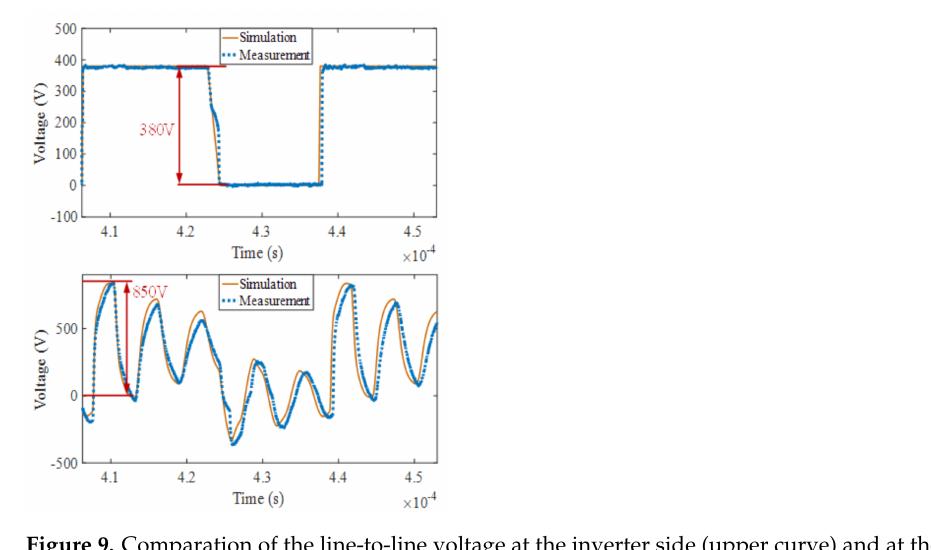
Figure 9. Comparation of the line-to-line voltage at the inverter side (upper curve) and at the motor side (bottom) with the proposed model.